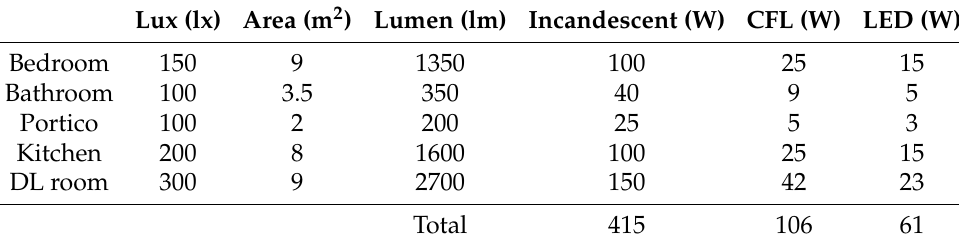
Table 2. Power consumption comparison of bulb technologies in an inhabited